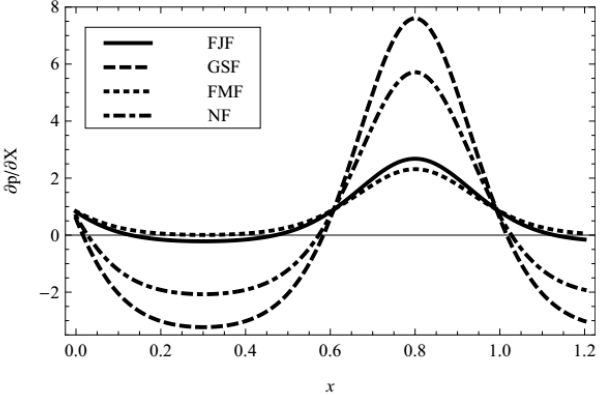
Figure 5. Profiles of the pressure gradient for various values of material parameter ( a ) λ 1 and ( b ) λ 2 with fixed α = 0.4, β = 0.6, m = 1, (cid:2038) = 0.3, (cid:1847) HS = 1, (cid:1843)(cid:3364) = 0.1, t = 0.8.